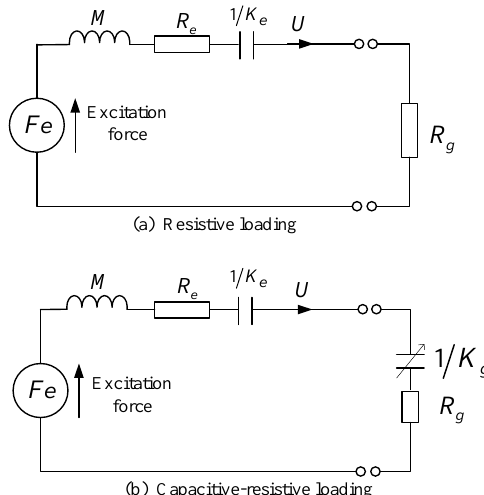
Figure 3. System model and loading of LWEC. ( a ) Resistive loading; ( b ) Capacitive-resistive loading.